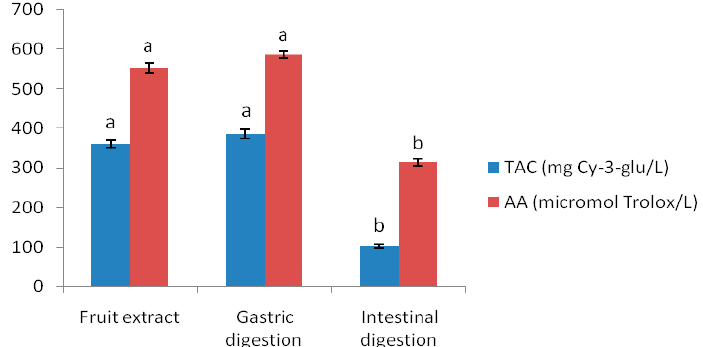
Figure 3. Changes in total anthocyanin content and antioxidant activity of Cornelian cherry fruit extract before and after in vitro gastrointestinal digestion. Means (bar value) with different letters are significantly different ( p < 0.05).